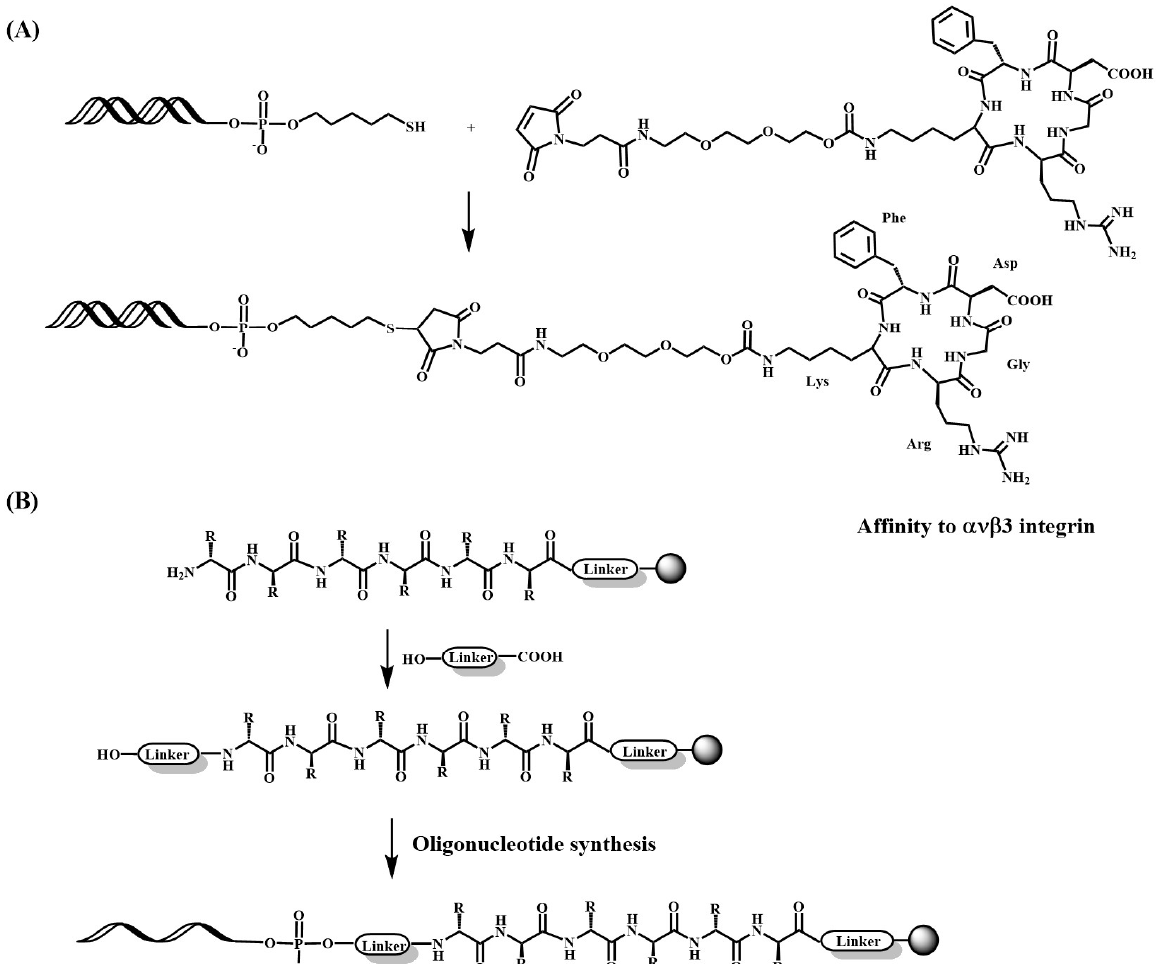
Figure 4. Preparation of oligonucleotide-peptide conjugates. ( A ) Postsynthetic conjugation of a thiol-oligonucleotide with a peptide by a maleimide moiety [124]. ( B ) Stepwise method for the synthesis of oligonucleotide-peptide conjugates on a solid support [113–116]. Oligonucleotides linked to cell penetration peptides (CPP) are among the most stud- ied conjugates [103,125] (Table 1). These short peptides can pass through cell membranes, facilitating the intracellular transport of various payloads. They can be: polycationic, with examples including Arg-rich [126,127], Tat peptide [128], Penetratin [129,130]; am- phipatic, for example Transportan [131], MAP-peptide [132]; proline-rich [133,134]; or hydrophobic, like C105Y [135], Pept1 [136] or MPM-peptides [137]. A similar strategy was developed consisting in the derivatization of antisense oligonucleotides with pep- tides that are recognized by membrane receptors, such as RGD peptides with affinity to integrins [138] or octreotate derivatives with affinity to somatostatin receptors [139]. Interestingly, these strategies combined with the addition of fusogenic peptides help endosomal escape